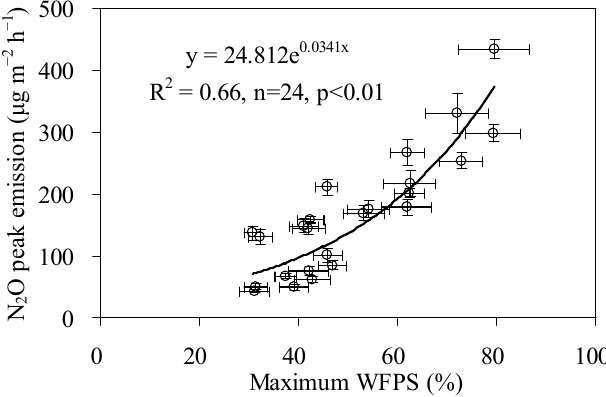
Figure 9. Relations between peak N 2 O fluxes and the maximum WFPS in SDI treatments.